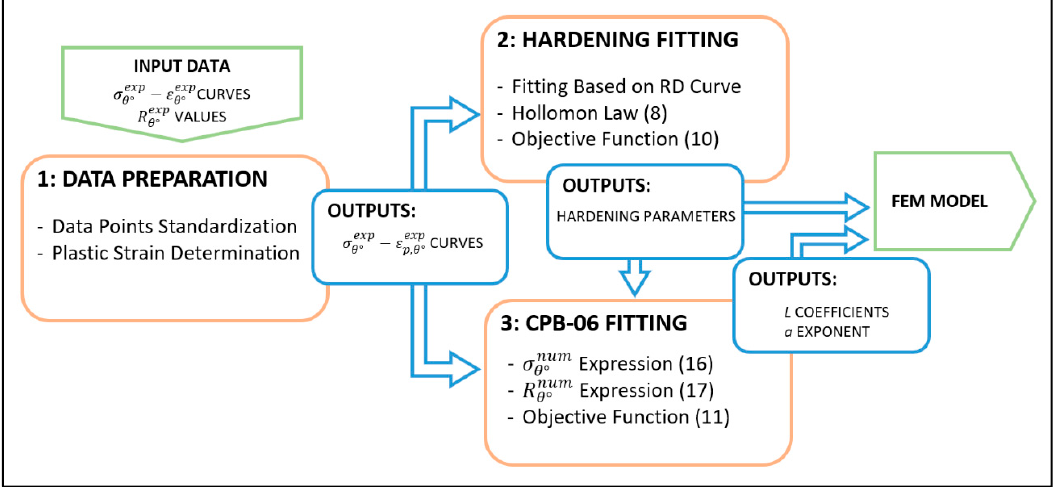
Figure 2. Flow diagram of the fitting procedure.